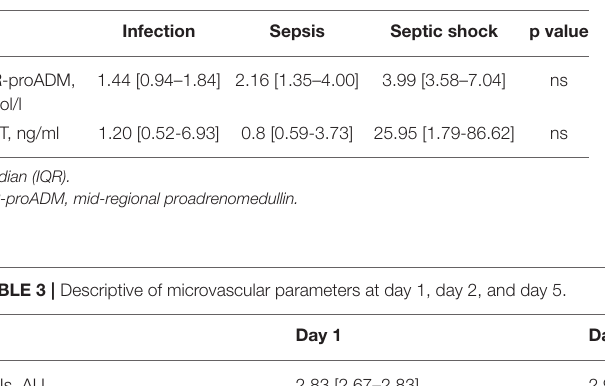
TABLE 2 | Day 1 plasmatic values of MR-proADM and procalcitonin (PCT).